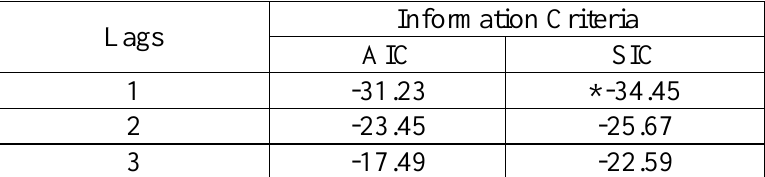
Table 3. Determining optimum lag length in the